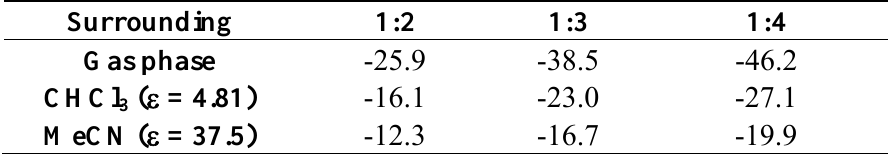
Table 5. The computed binding energies (in kcal/mol) of the prepolymerization- complexation between nia and MAA shown in Figure 3 in gas phase and in the different polar surroundings.